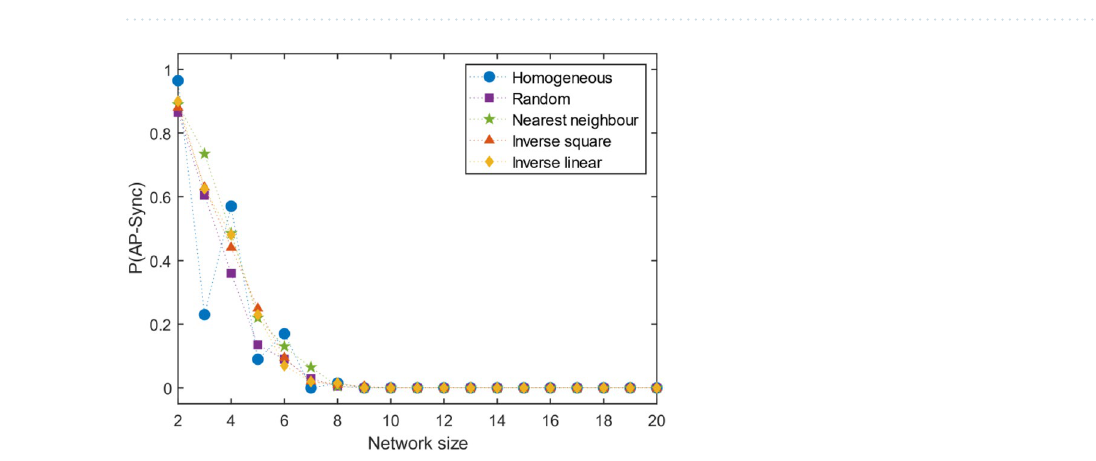
Figure 6. Simultaneous presence of attractive and repulsive coupling. For the more general case of arbitrary direction of coupling, the overall result presented holds, however a regime of preference for AP synchronization is observed.